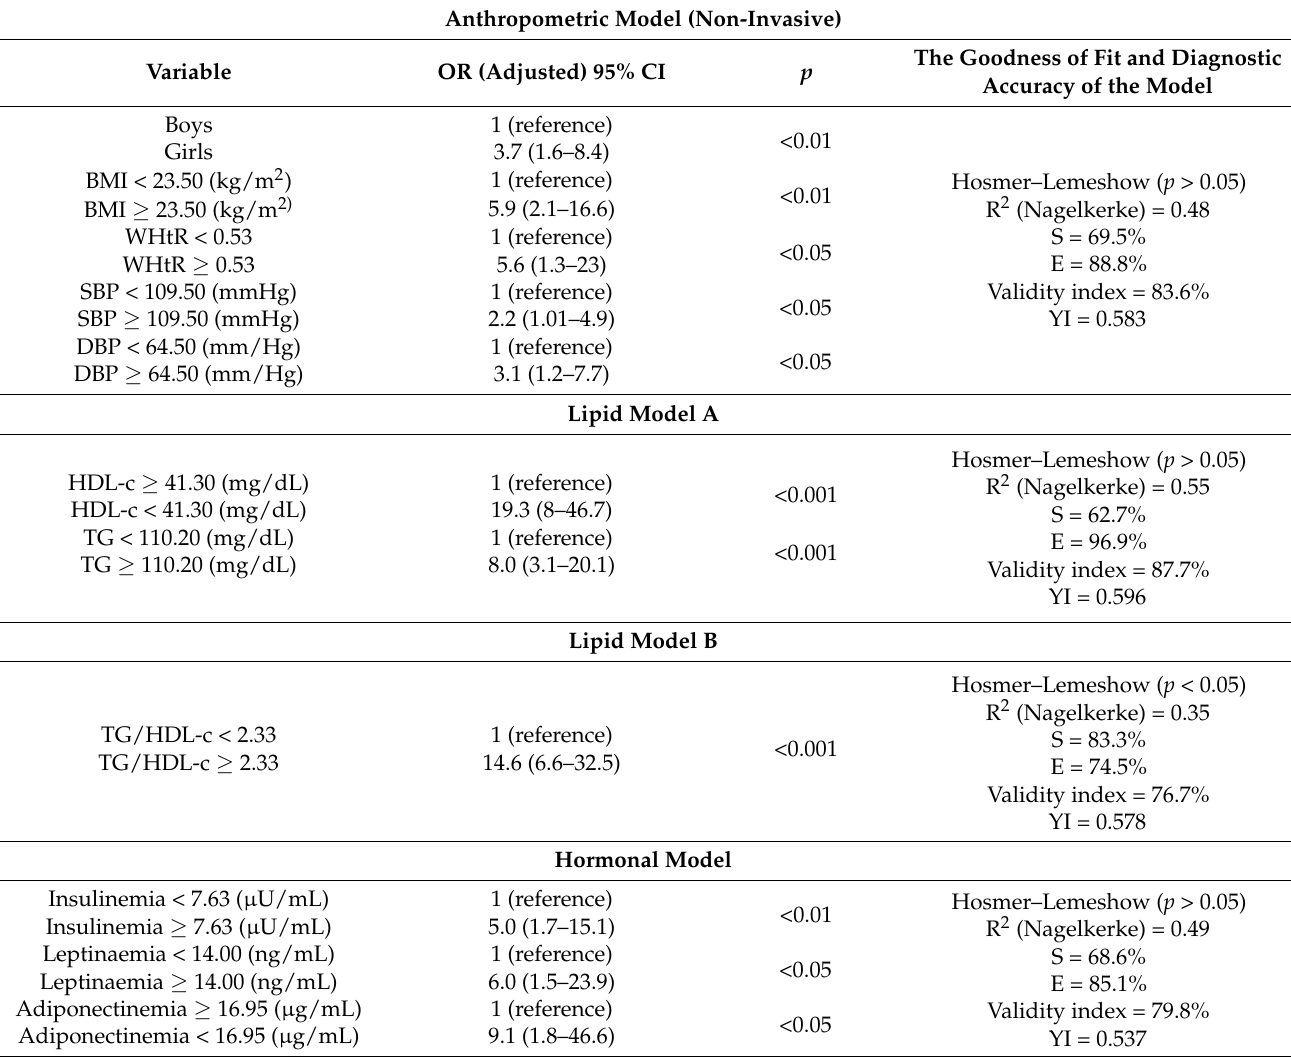
Table 4. Logistic regression models adjusted by age and